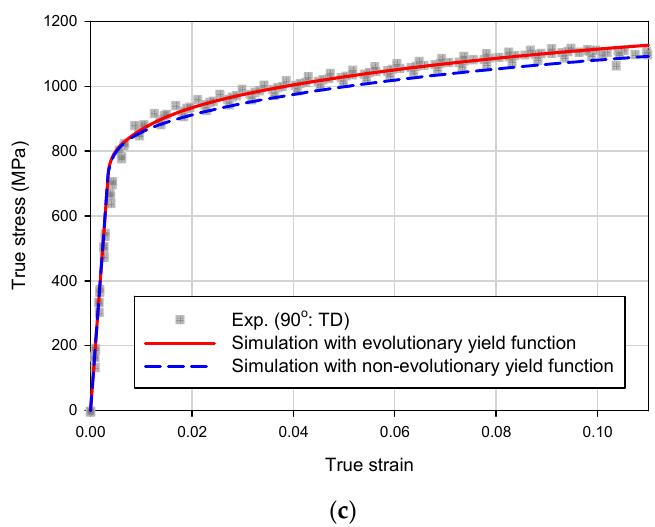
Figure 15. Comparison of the measured and simulated true stress–strain curves for ( a ) 0, ( b ) 45 and ( c ) 90 degrees off tensile directions for the Q&P 980 steel.